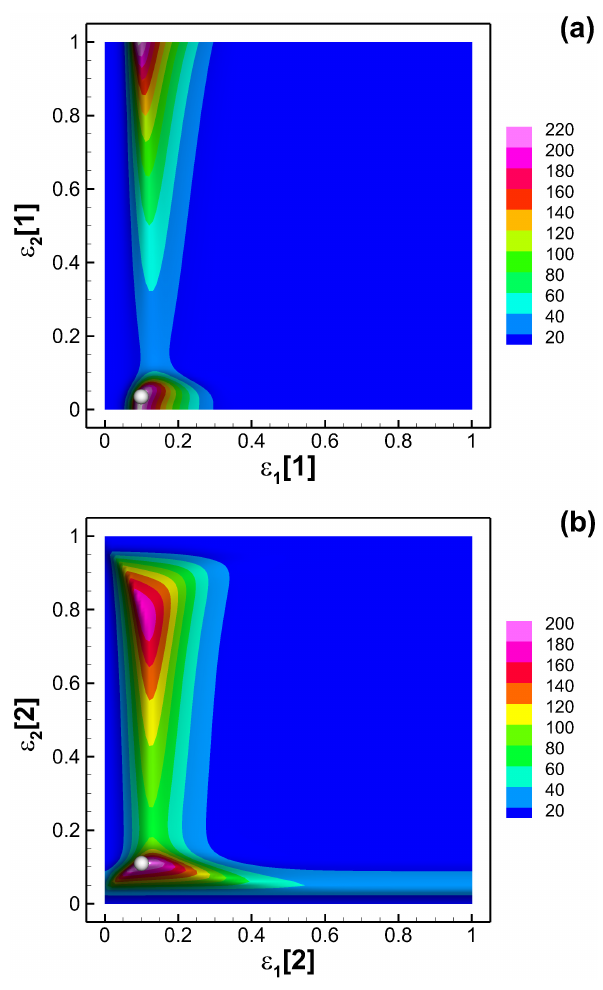
Fig. 8. Interal entropy production in (a) box [1], Eq. (14), as a function ε 1 and ε 2 in box [1] for a fixed value of ε 1 and ε 2 in box [2] of 0.0997 and 0.1100, respectively, and (b) in box [2], Eq. (15), as a function ε 1 and ε 2 in box [2] for a fixed value of ε 1 and ε 2 in box [1] of 0.0991 and 0.0352, respecitvely. White point in (a)